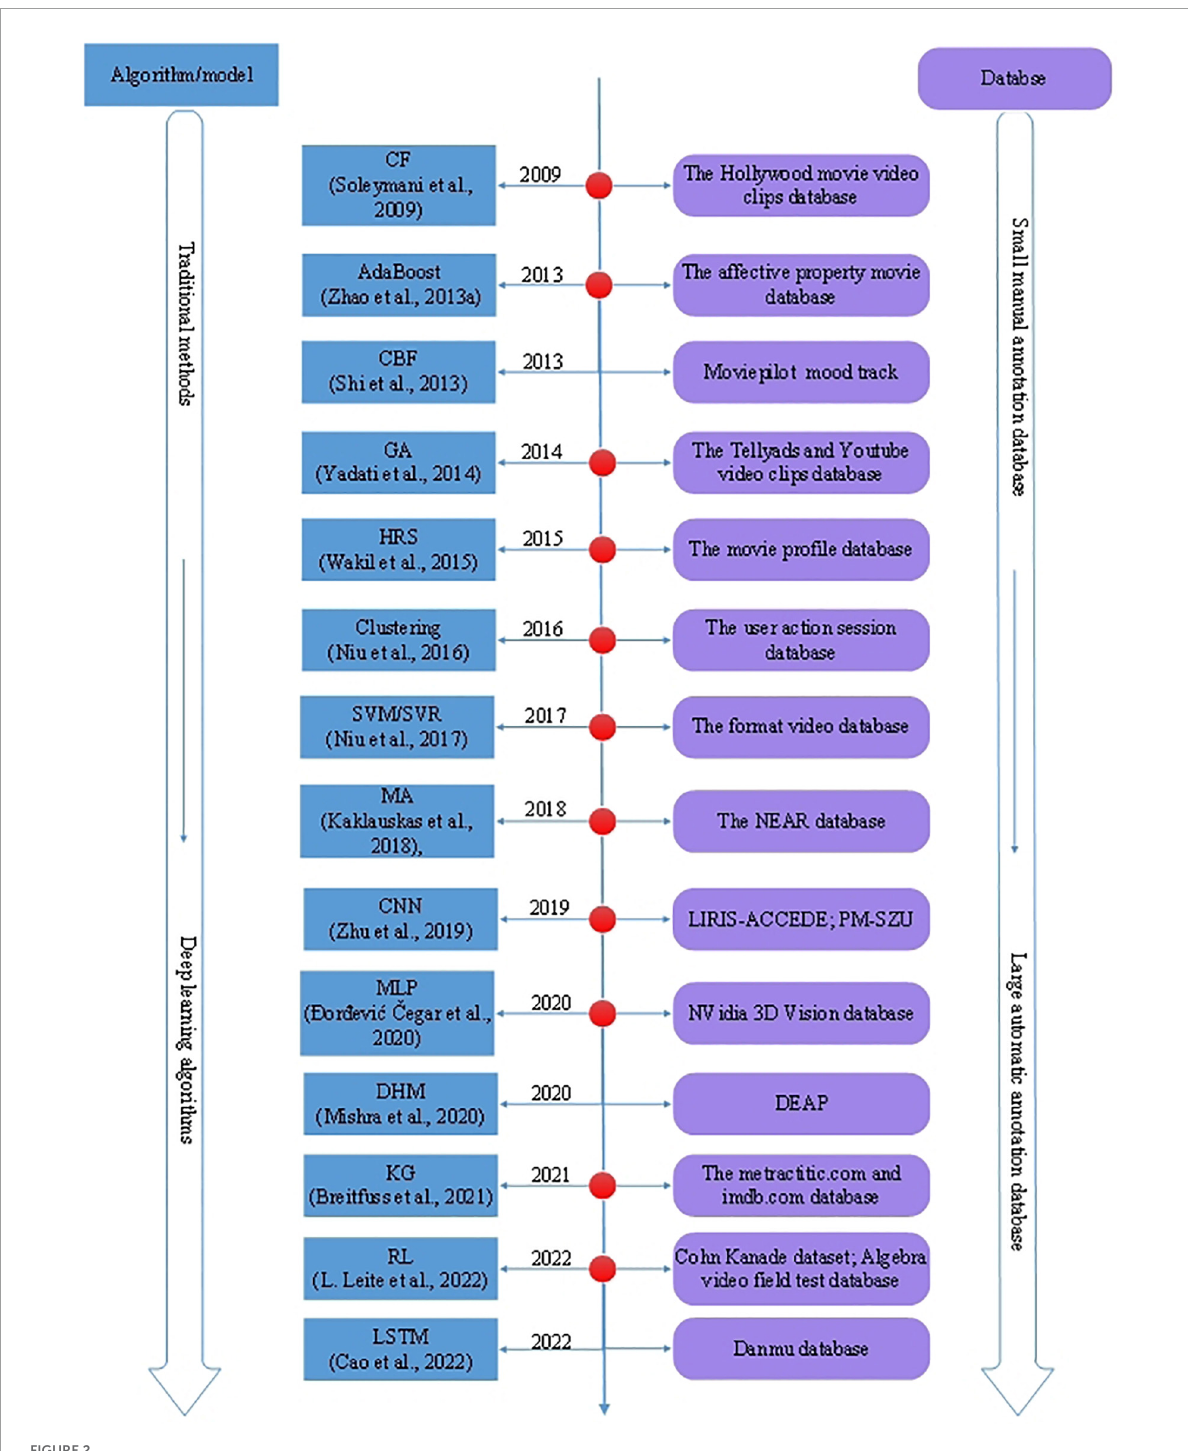
An SVM/SVR is one of the most widely-used techniques in the affective video recommendation domain.